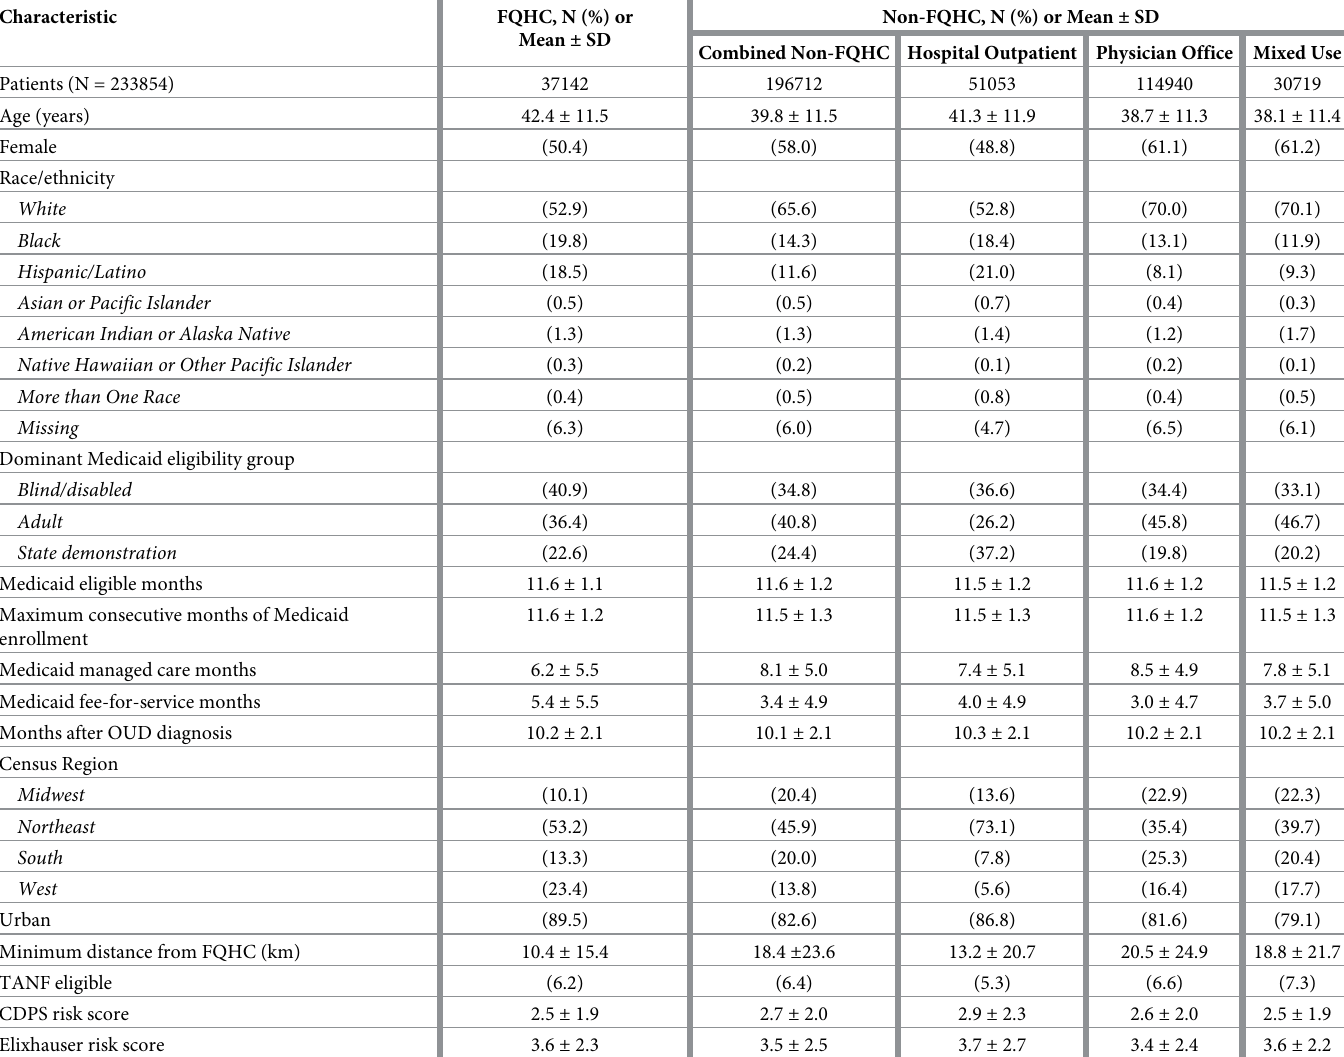
Table 1. Characteristics of patients with at least six months of continuous Medicaid enrollment after OUD diagnosis by primary care setting: United States, 2012.